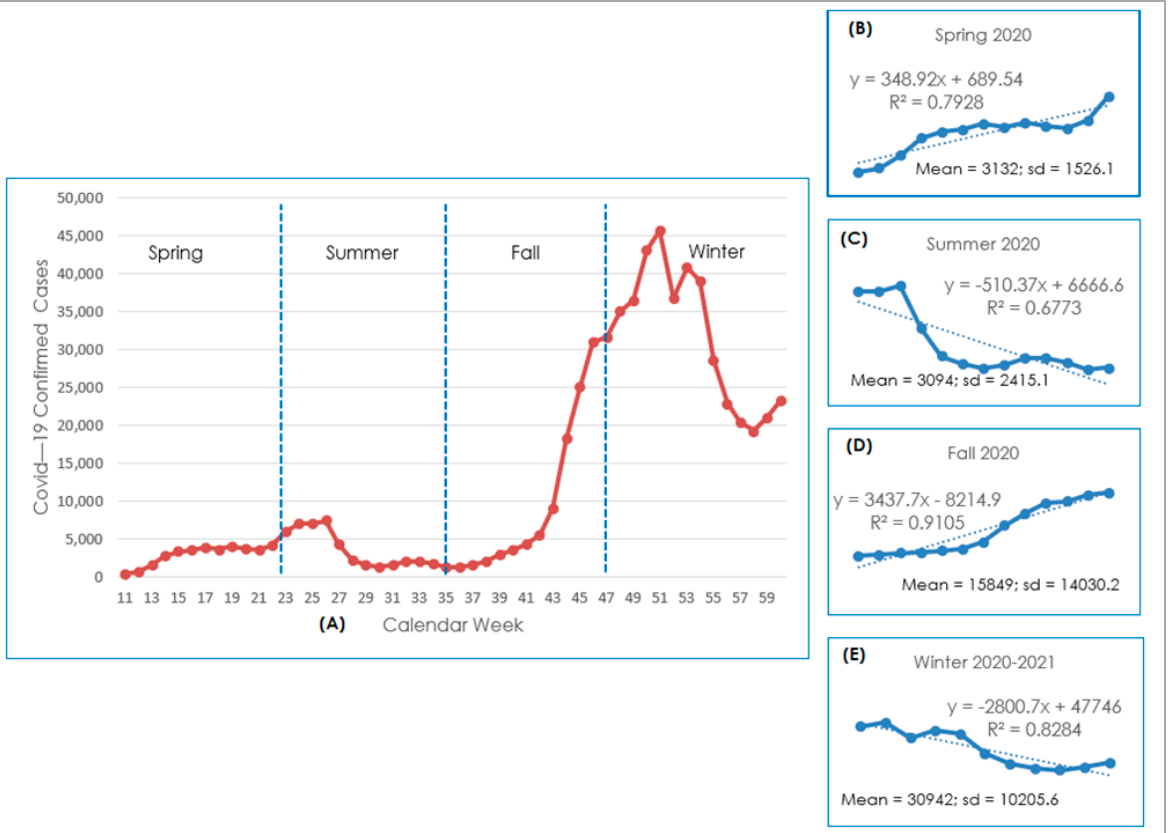
Figure 2. COVID-19 weekly reported cases within the four seasons. ( A ) shows the general trends for all the seasons; ( B ) shows the trend in Spring; ( C ) shows the trend in Summer; ( D ) shows the trend in Fall; and ( E )shows the trend in Winter.